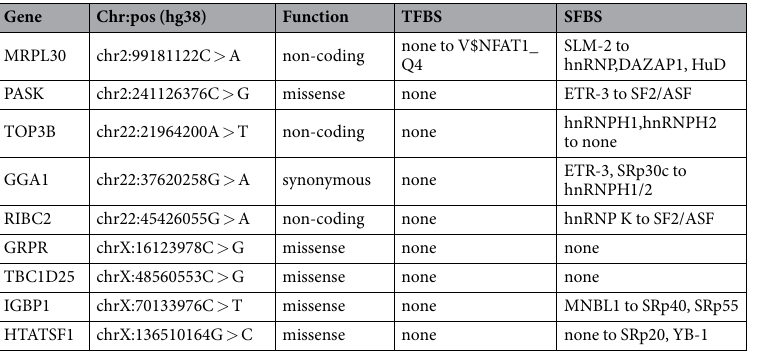
Table 1. SOM-E mutations in non-GCG genes: location within transcription and splicing factor recognizable